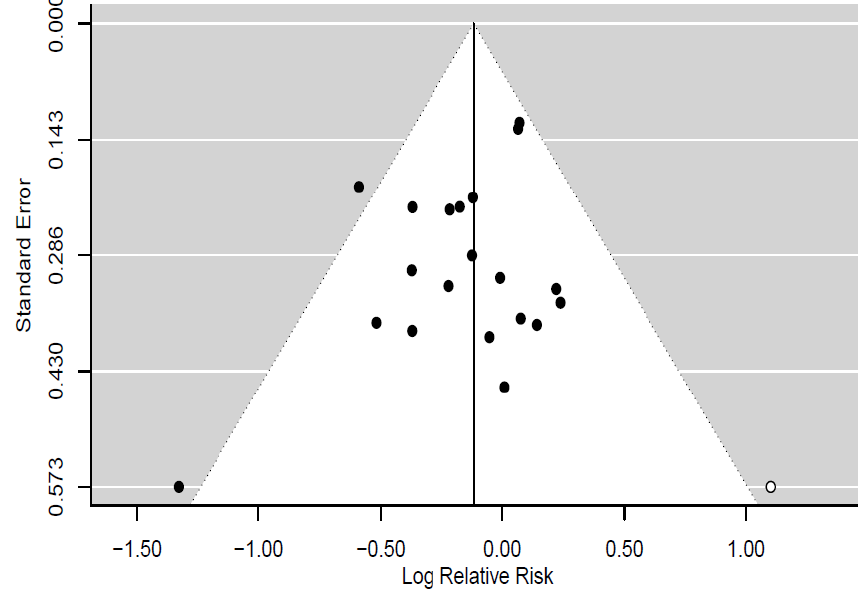
Figure 10. Funnel plot based on the trim and fill method for random effects